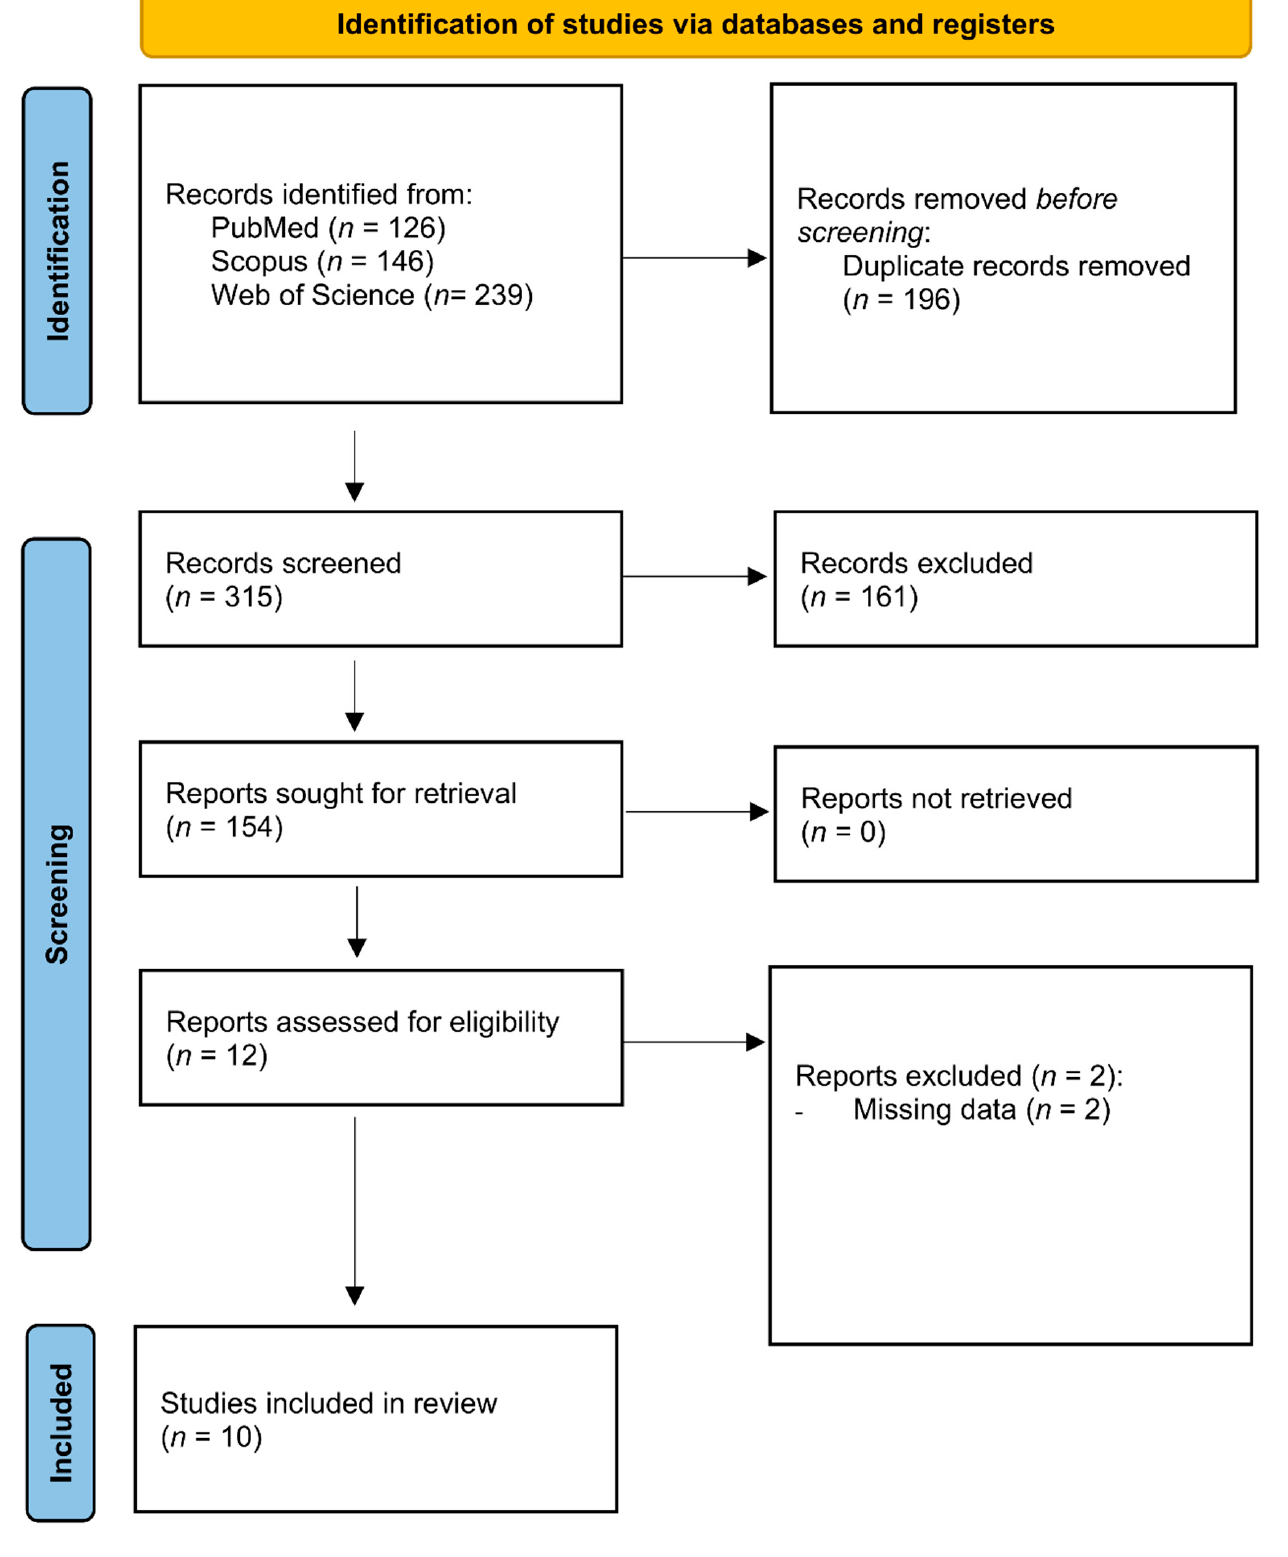
Figure 1. PRISMA flow diagram.